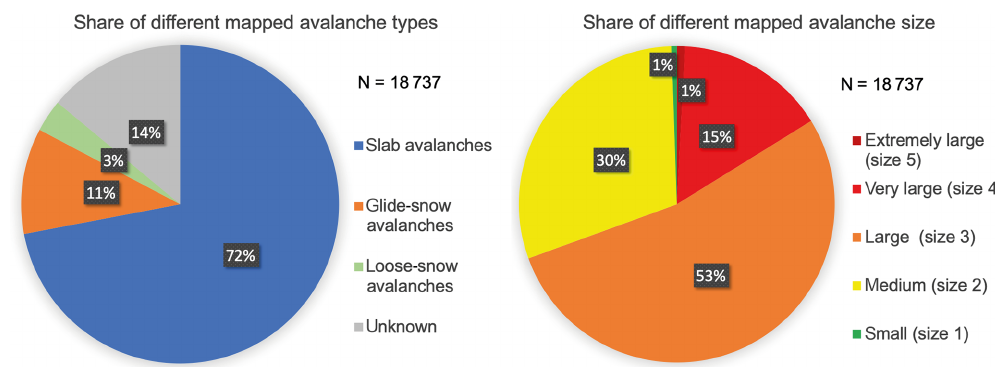
Figure 5. Type and size of the different mapped avalanches.